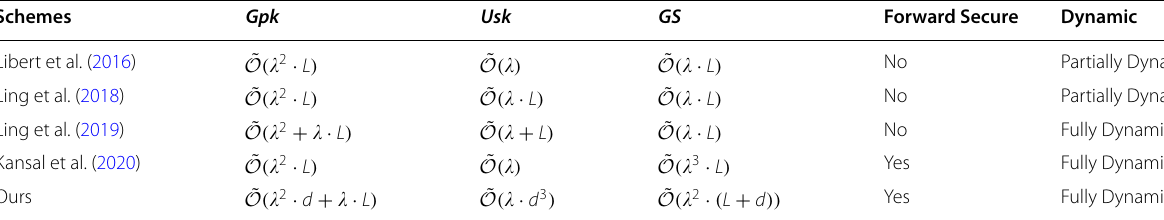
Table 1 Comparison among lattice-based dynamic signature schemes Schemes